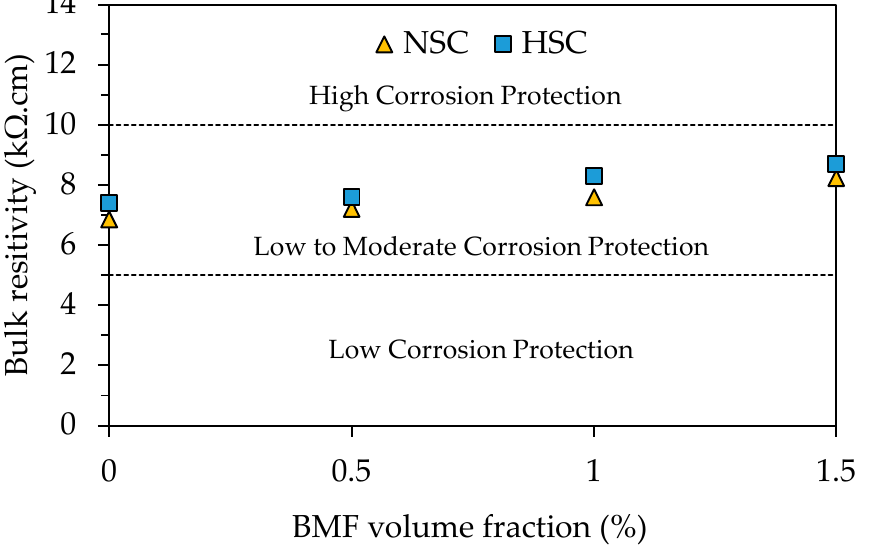
Figure 19. Bulk resistivity versus BMF volume fraction